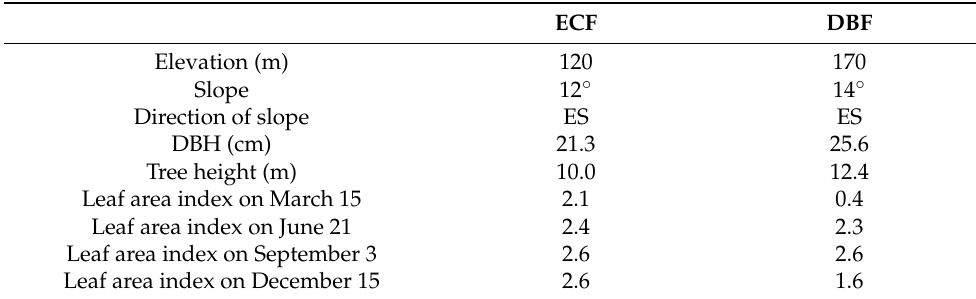
Table 1. The characteristics of the evergreen coniferous forest (ECF) and deciduous broadleaved forest (DBF) in